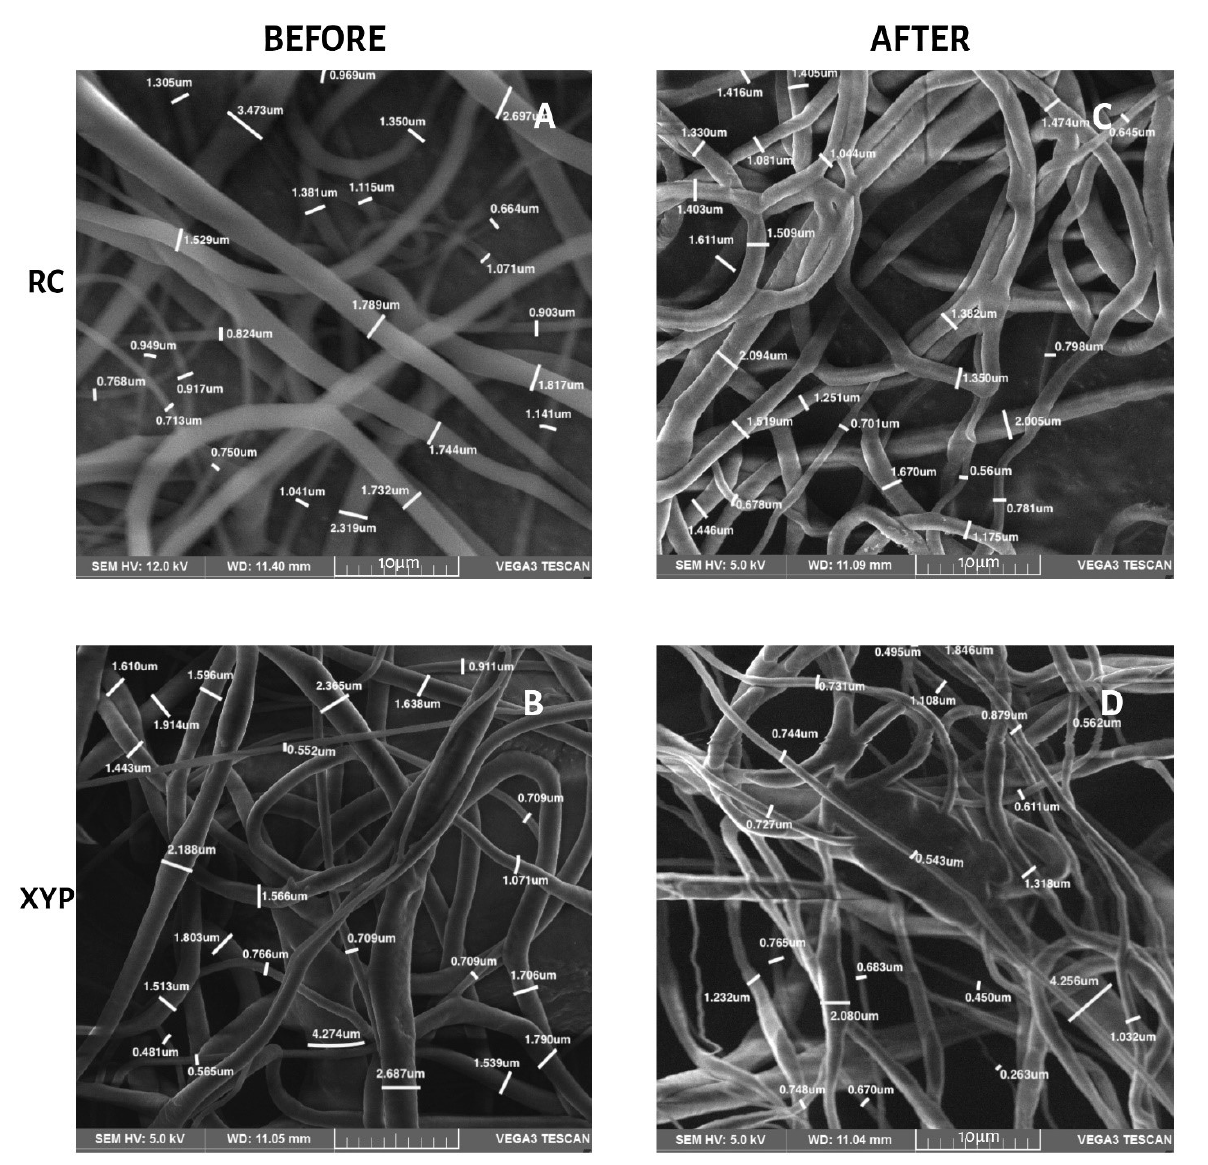
Figure 5. Fiber diameter in SEM micrographs, 90 min of deposition. ( A ) RC90 before mechanical tests, ( B ) XYP90 before mechanical tests, ( C ) RC90 after mechanical tests, ( D ) XYP90 after mechanical